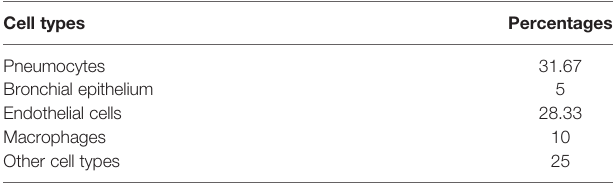
TABLE 1 | ADAM17 RNA expression in different cells from the